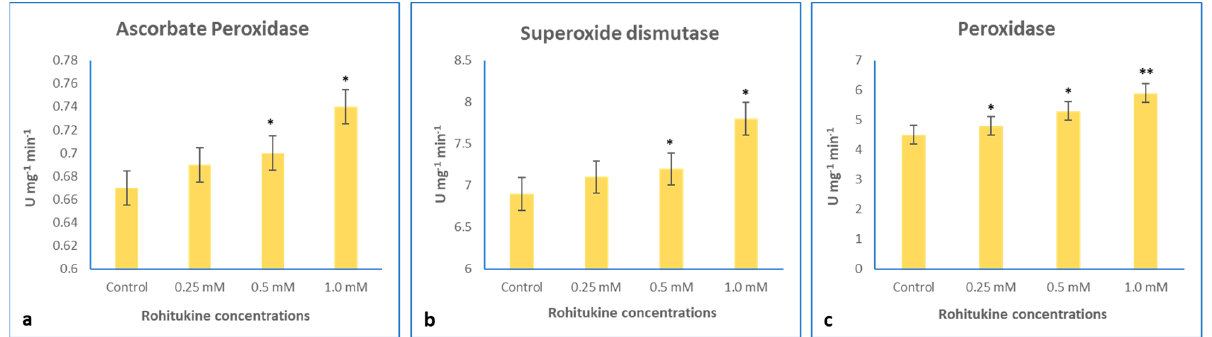
Figure 6. Effects of 0.25 mM, 0.5 mM and 1.0 mM rohitukine on ( a ) APX, ( b ) SOD and ( c ) POD of five-week-old A. thaliana plants treated with rohitukine. Data are presented for the treatments as means ± SDs ( n = 3). Statistical significance was determined by Dunnett’s multiple comparisons test. Asterisks * and ** denote significance level at p -values< 0.5 and 0.05, respectively.